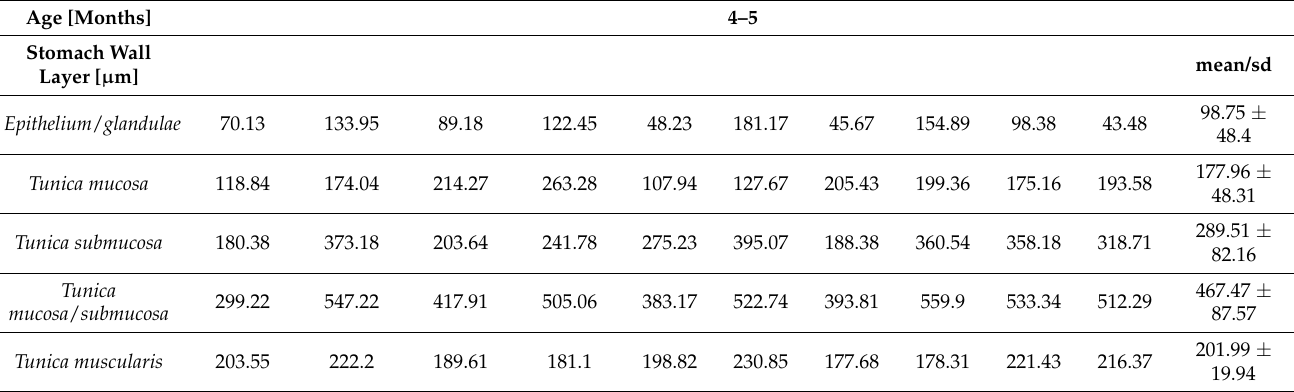
Table 2. Histometry of equine stomach—the stomach body ( corpus ventriculi